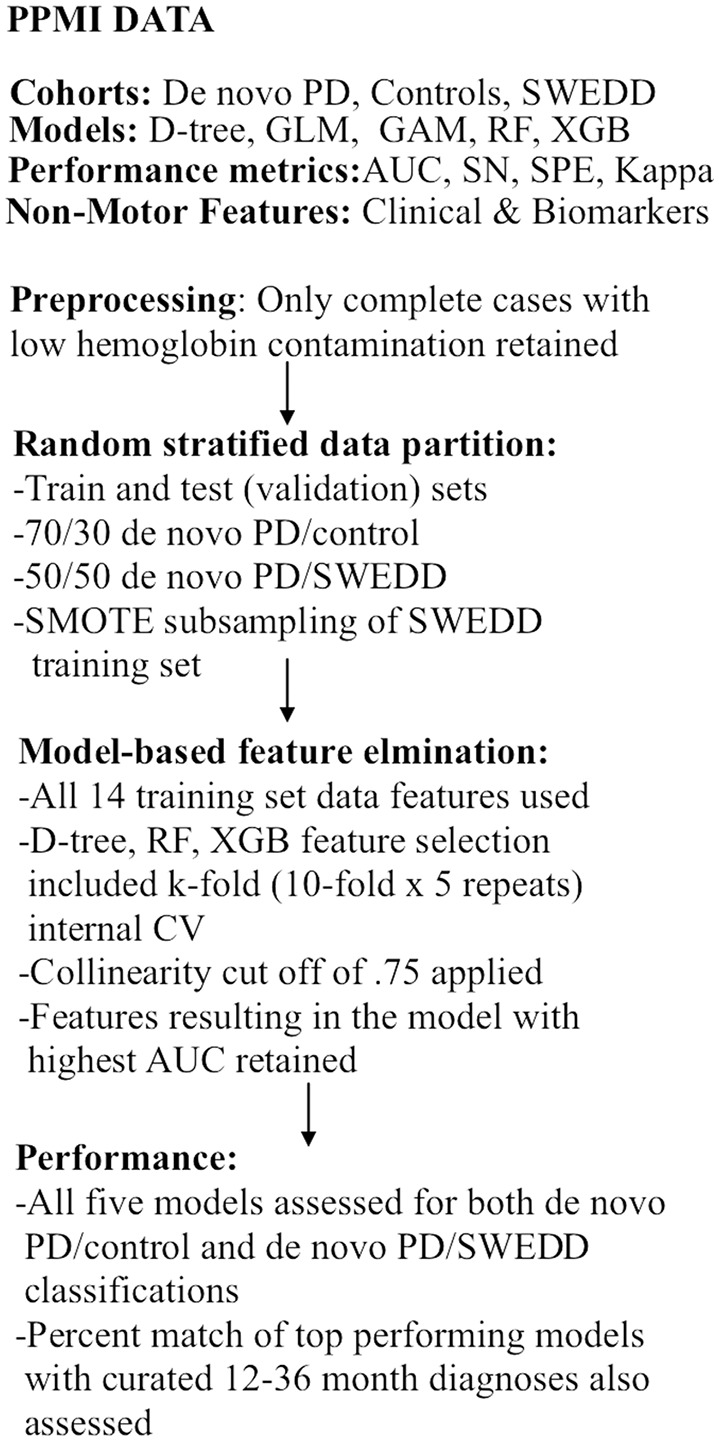
Analyses flow chart. CV, cross-validation; GAM, general additive model; GLM, logistic re-gression; AUC, receiver operator characteristic area under the curve; RF, random forest; SMOTE, synthetic minority oversampling technique; SN, sensitivity, SPE, specificity; SWEDD, scans without evidence of dopamine deficit.